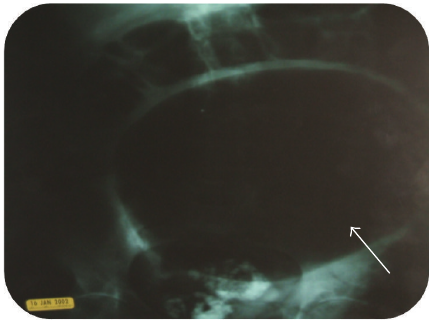
Figure 1: Abdominal X-ray showing air fluid level with a dilated loop of sigmoid